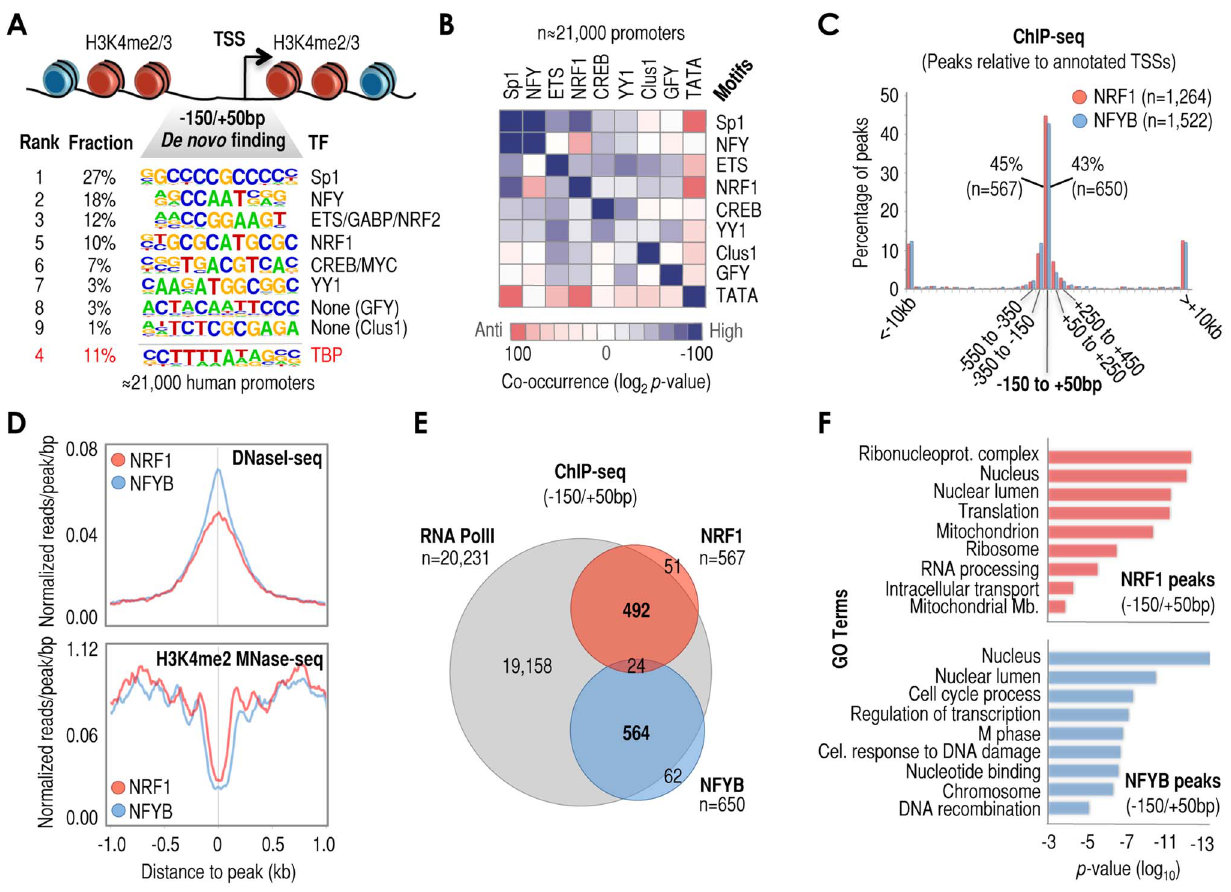
Figure 1. A series of cis-regulatory elements (here termed ‘cardinal’ motifs) are highly enriched at 2 150/ + 50 bp relative to TSS ( + 1) and may define different subsets of human promoters. ( A ) Most human promoters contain ‘open’ chromatin regions at 2 150/ + 50 bp relative to + 1, or TSS. These regions are surrounded by heavily modified nucleosomes containing H3K4me2/3 (depicted in red in the vignette). We have identified the most enriched cis-regulatory elements in these particular regions by de novo motif discovery analysis of n=21,000 human promoters. The panel shows rank of element enrichment, fraction of promoters containing these elements, consensus sequence, and cognate TF when known (e.g. NRF1 or NFY) or when proposed (e.g. Clus1). We refer to these elements as ‘cardinal’ motifs, and to the TFs that recognize them as ‘cardinal’ TFs. ( B ) Analysis of motif co-occurrences among cardinal motifs. Results are shown as a matrix of co-occurrences based on the analysis of n=21,000 human promoters ( 2 150/ + 50 bp). Co-occurrence log 2 p -values are shown as a gradient of blue-to-red for positive-to-negative co-occurrences, and as white in the absence of significant co-occurrence. ( C ) Positional binding analysis of cardinal TFs NRF1 (red) and NFYB (blue) with respect to 2 150/ + 50 bp genomic regions in MCF7 cells, based on ChIP-seq data. The x-axis refers to genomic distances with respect to 2 150/ + 50 bp (center of the panel). Genomic windows span: 200 bp (between 2 150/ + 50 bp and 6 2 kb), 1 kb (between 6 2 kb and 6 10 kb), and the rest of distances together (beyond 6 10 kb). The y-axis refers to percentage of the total of NRF1 and NFYB peaks in each genomic range. The total number of peaks (n) and the specific number of peaks within 2 150/ + 50 bp regions (n) are also indicated in the panel. ( D ) Meta-analysis of sequencing read density based on DNaseI-seq (top) and H3K4me2 MNase-seq (bottom) around NRF1 (red) and NFYB (blue) ChIP-seq peaks (both at the center of the panel). ( E ) Venn diagram depicting the overlap of RNA PolII (grey circle), NRF1 (red circle), and NFYB (blue circle) ChIP-seq peaks in MCF7 cells. We considered as ‘overlap’ the coincidence of NRF1 and NFYB peaks in the same 2 150/ + 50 bp region. Also, we considered as ‘overlap’ the coincidence of RNA PolII peaks within 6 1 kb of a TSS containing NRF1 or NFYB peaks at 2 150/ + 50 bp. ( F ) Functional (gene ontology, or GO) analysis of genes with NRF1 (top) or NFYB (bottom) ChIP-seq peaks in their 2 150/ + 50 bp regions. P -values (log scale) are shown in the x -axis. GO terms are indicated in the